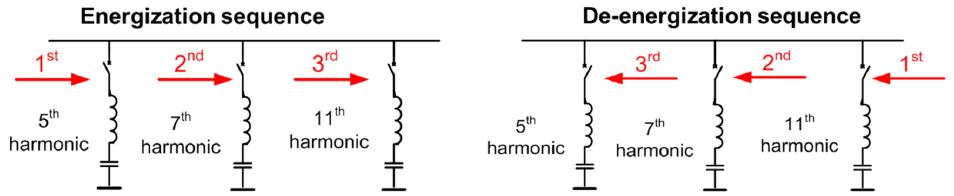
Figure 4. Switching sequence of multiple single-tuned harmonic filters.